Question: Name the type of graph shown.
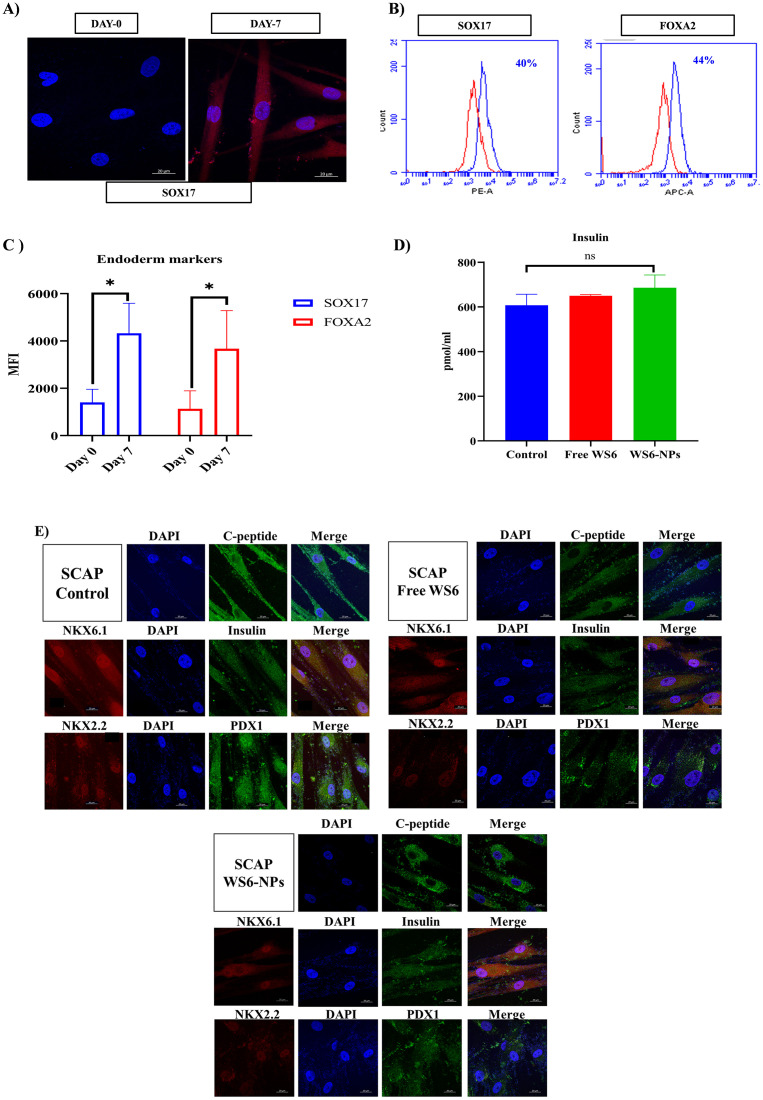
Answer: histogram